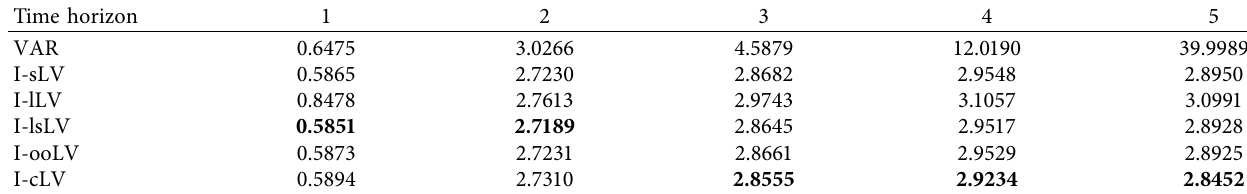
Table 5: Average RMSE across all spots for the diferent I-LV structures.